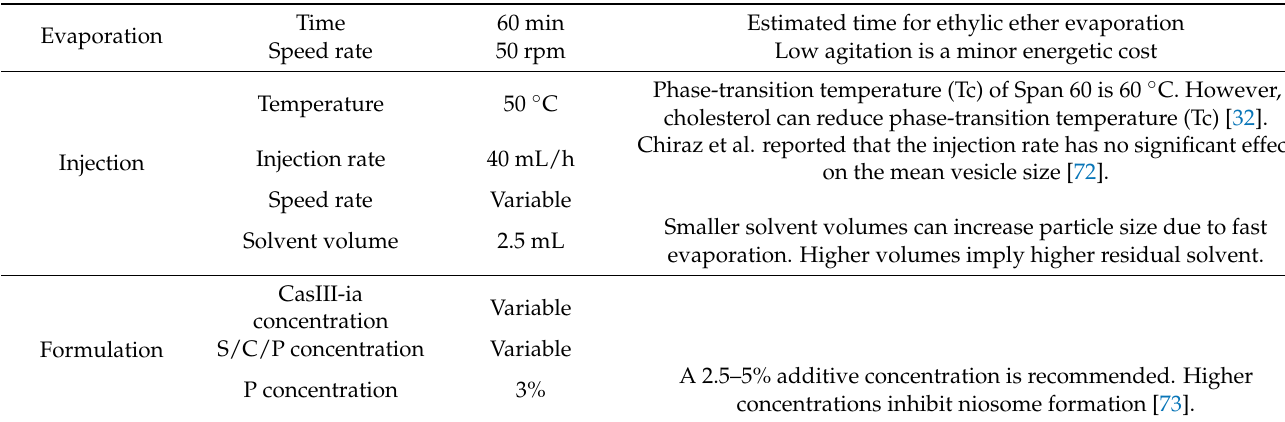
Table 7. Conditions for niosome formation in factorial design 2 3